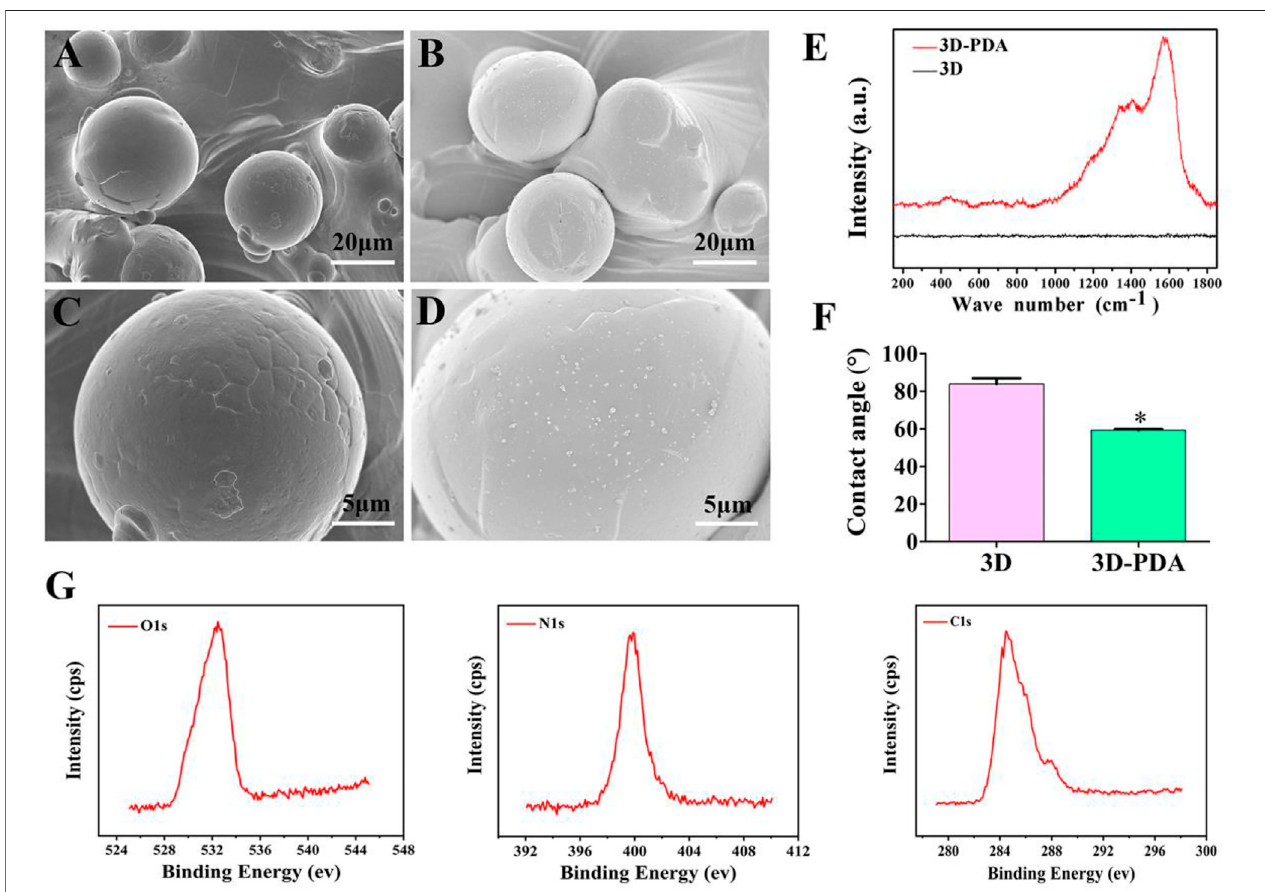
FIGURE1| SEMimagesof3D (A,C) and 3D-PDA (B,D) atlow (A,B) and highmagni fi cations (C,D) .Ramanspectraanalysis (E) ,watercontactangle (F) of3Dand Q15 3D-PDA group surfaces, and X-ray photoelectron spectroscopy spectra of the 3D-PDA surface (G) . * p < 0.05.